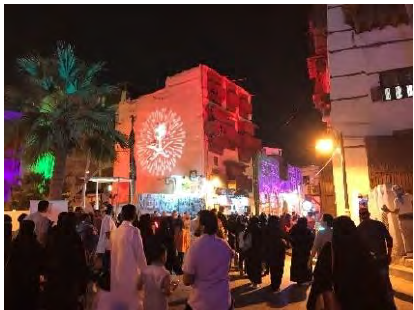
Figure 7. Shows the gathering node near